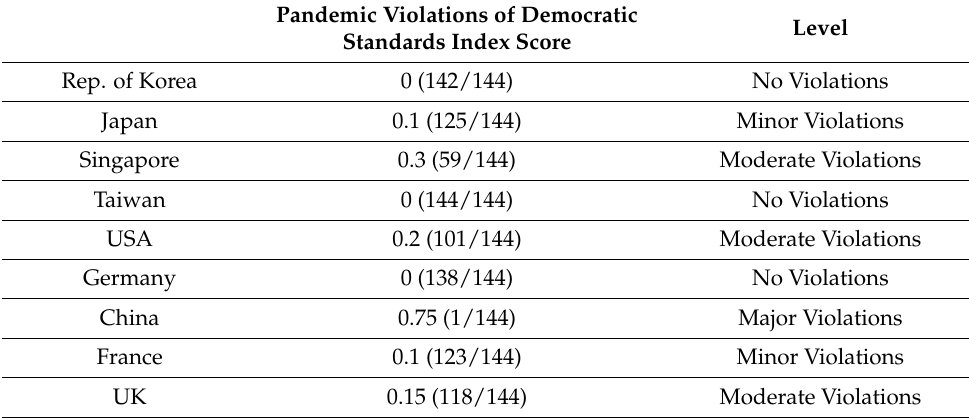
Table 2. Pandemic Violations of Democratic Standards Index Score. Pandemic Violations of Democratic Standards Index Score